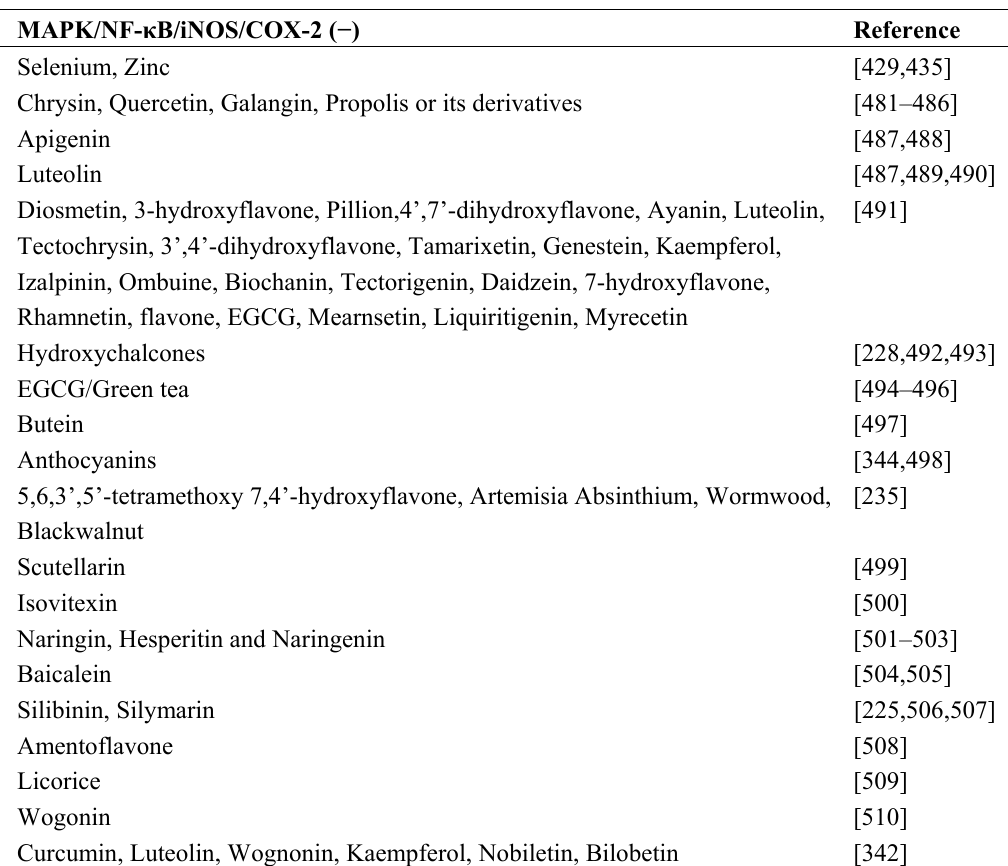
Table 9. MAPK/NF- κ B/iNOS/COX-2 ( −